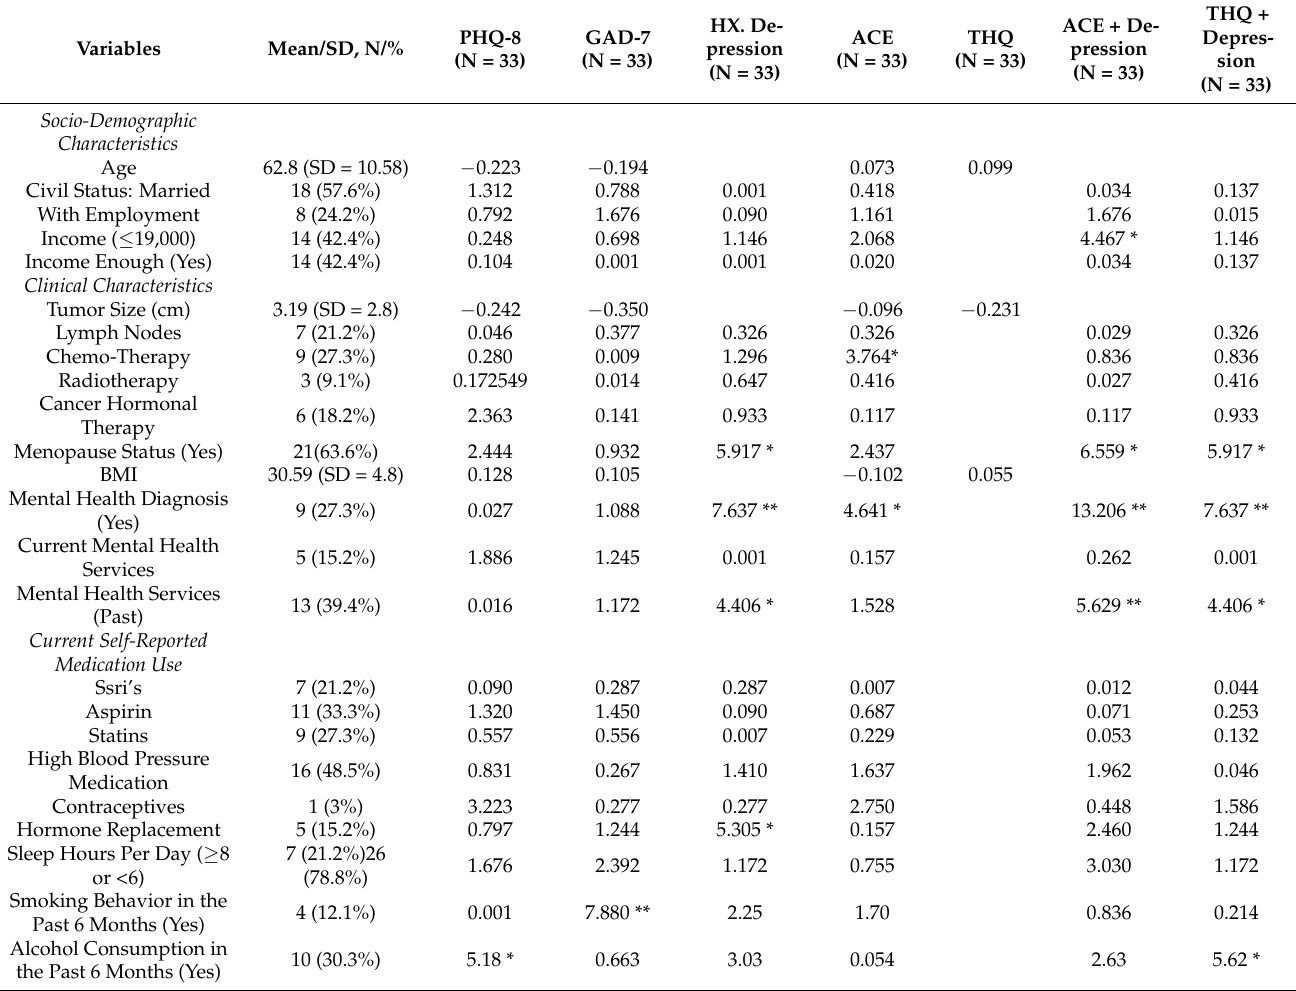
Table 1. Participants’ characteristics and correlations with behavioral outcome